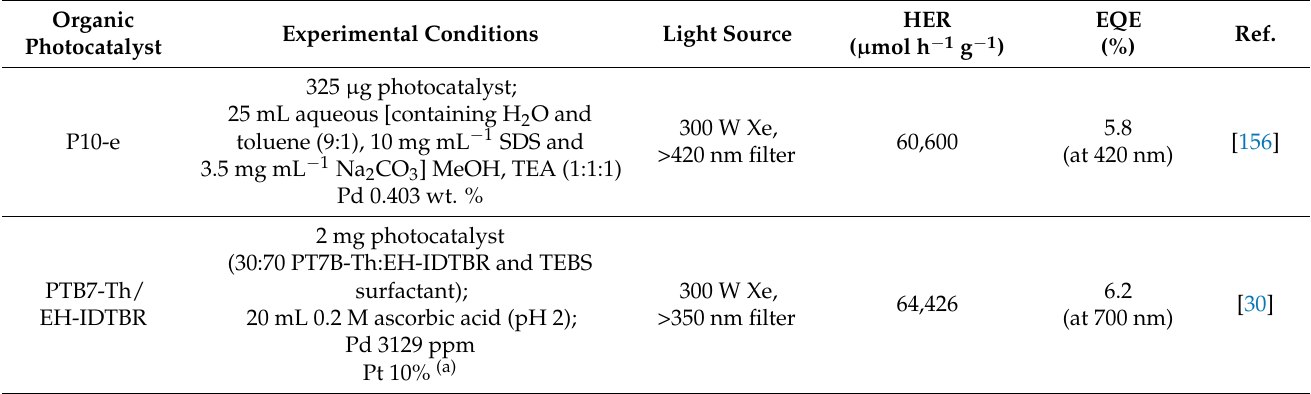
Table 3. Comparison of photocatalytic activity associated involving materials with relatively large internal surface